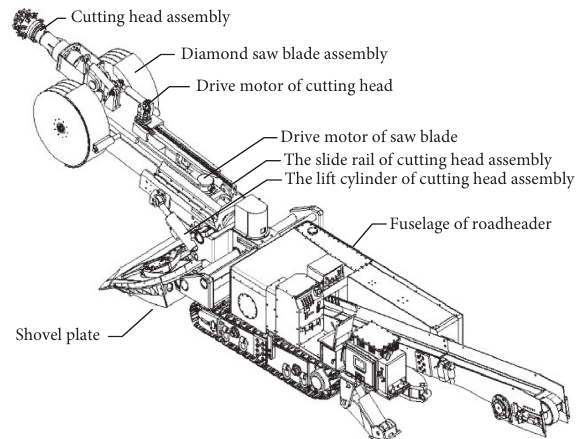
Figure 2: Schematic drawing of the roadheader combing diamond saw blade and conical